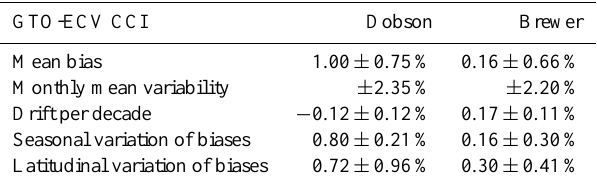
Table 4. The statistics following the Figures presented in Sect. 3.2 for the Northern Hemisphere.